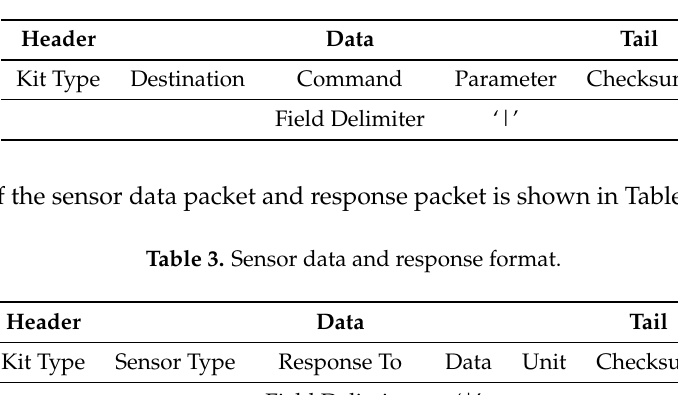
Table 2. Text-based Command format.